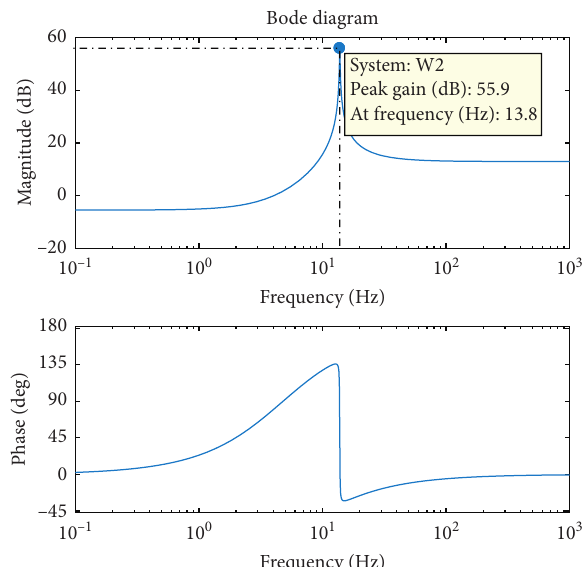
Figure 6: Bode diagram of the weighting function W